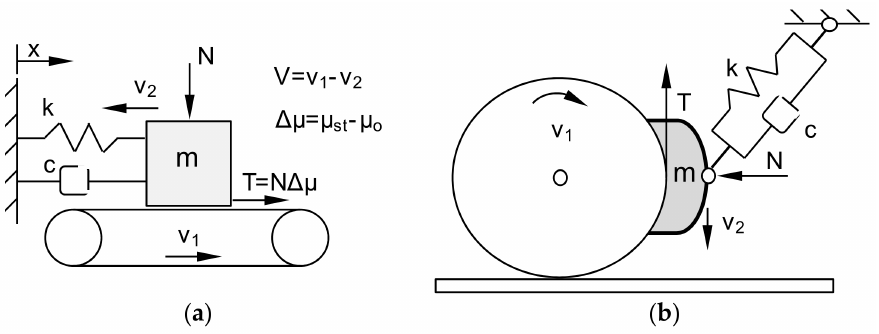
Figure 1. Brake system models: ( a ) Model of an elastic friction system on the example of a conveyor belt (stick-slip phenomenon), k—spring stiffness, c—viscous damping coefficient, m—block mass, N—pressure force on the conveyor belt, T—friction, V—relative speed, v 1 —conveyor belt speed, v 2 — pad speed, µ st —static friction coefficient, µ o —kinetic friction coefficient, x—displacement; ( b ) Model of the actual brake system 1Bg in the railway block